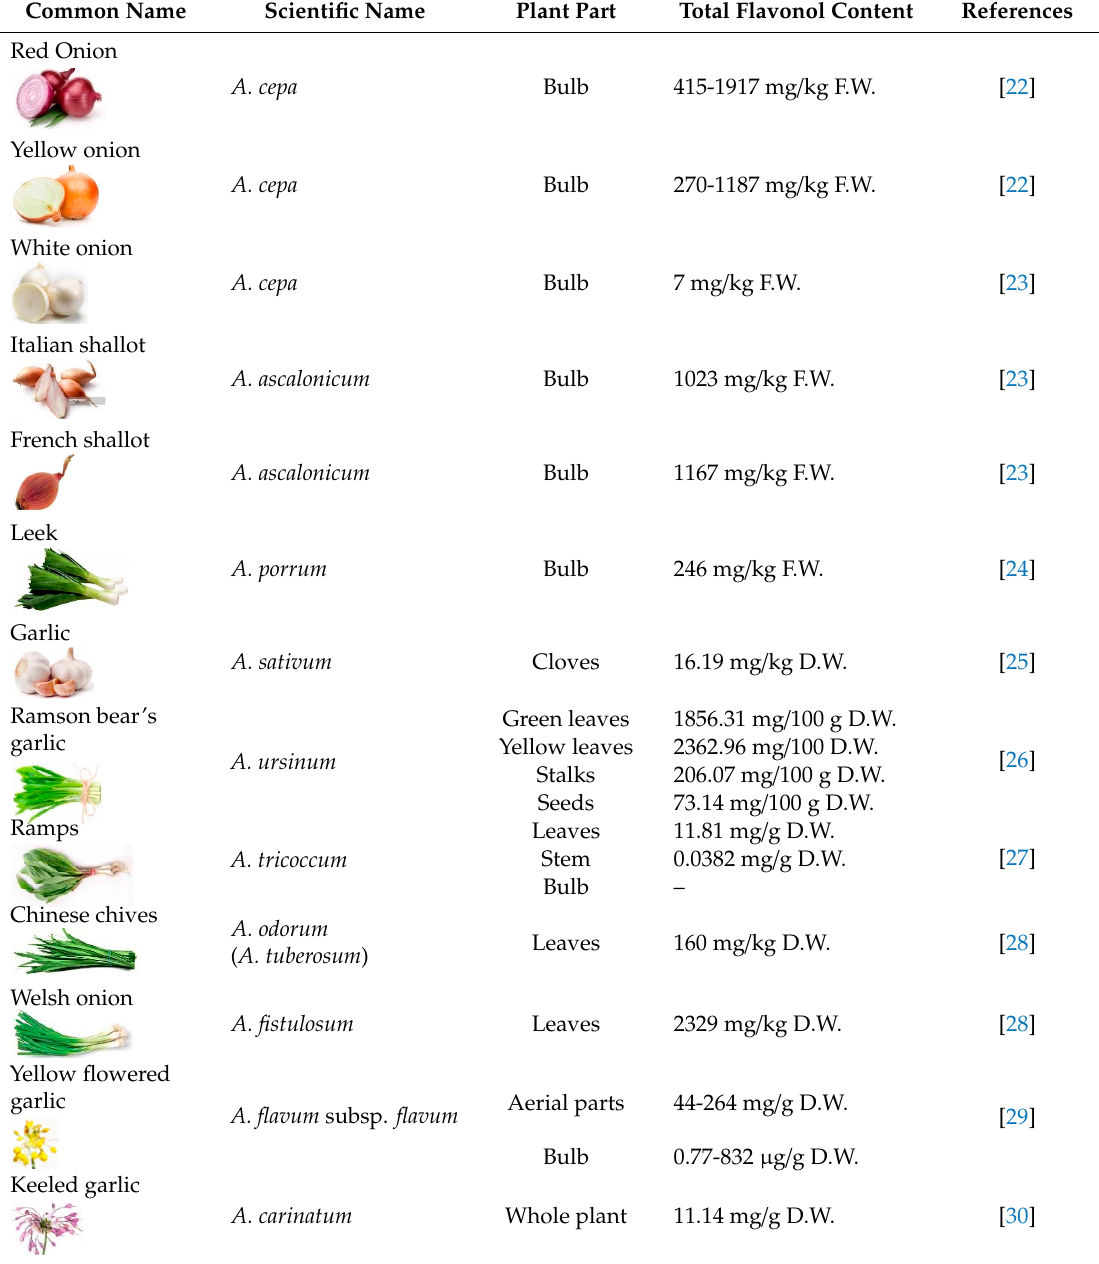
Table 1. Flavonol contents of some common edible Allium species.